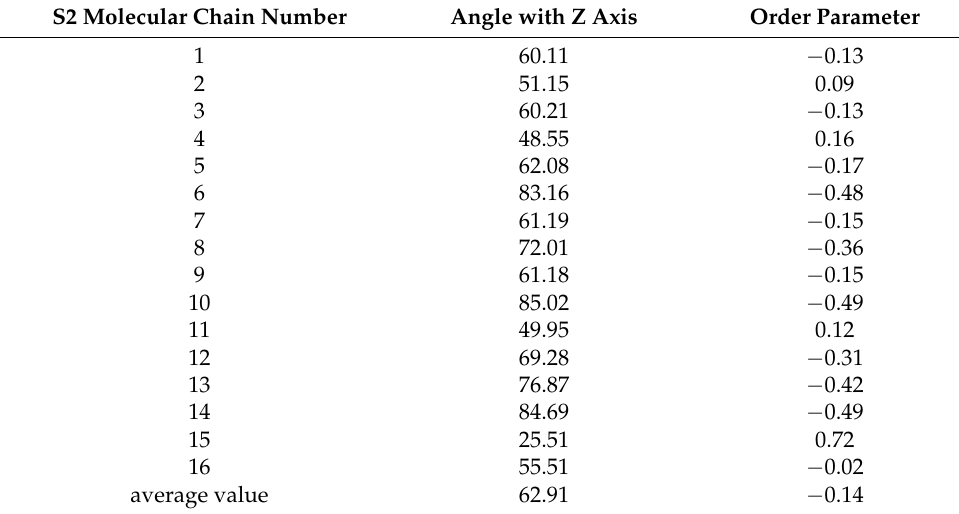
Table 3. The angle between the SDS molecule and the Z axis and order